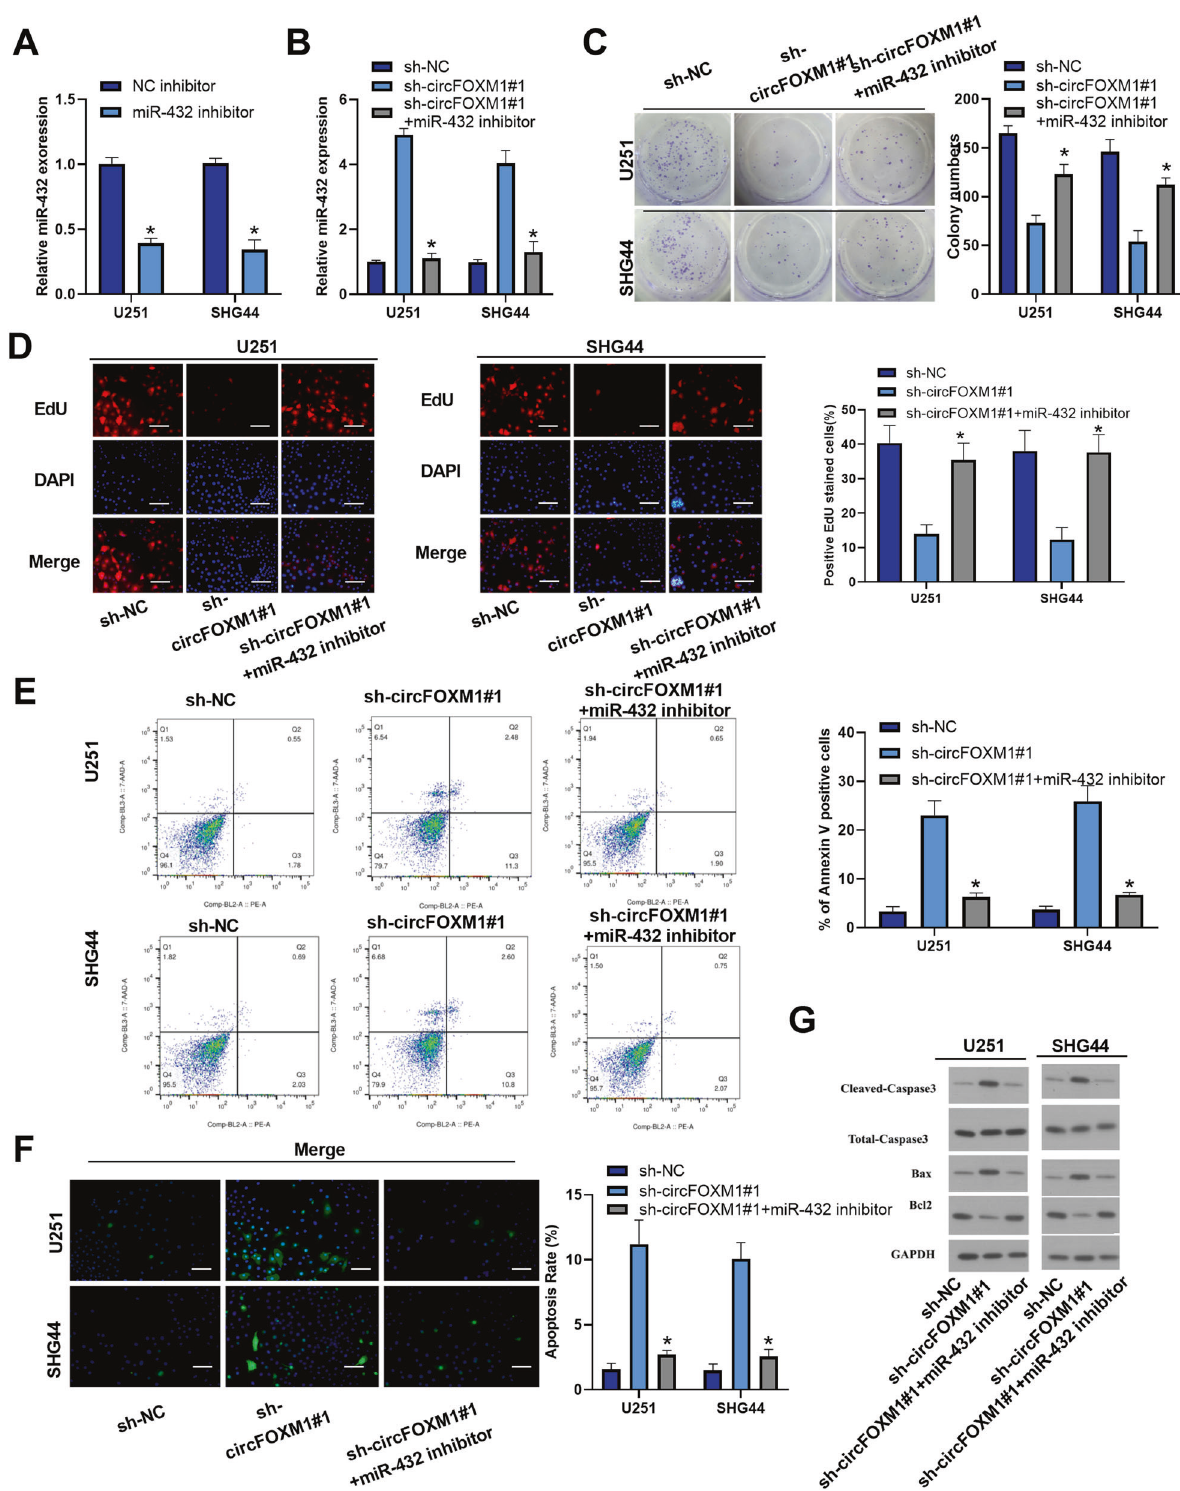
Fig. 5 miR-432 inhibition rescues the effects of circFOXM1 knockdown on glioma cells. A , B MiR-432 knockdown ef fi ciency and its expression in different transfection groups were examined by qRT-PCR in U251 and SHG44 cells. C , D The proliferation ability of glioma cells was detected by colony formation and EdU assays in response to knockdown of circFOXM1. E , F Apoptosis of glioma cells detected by fl ow cytometry analysis and TUNEL assay. G Western blot was used to measure the expression of apoptosis-related proteins in glioma cells with or without circFOXM1 silencing (* P < 0.05) (scale bar = 100 μ m).